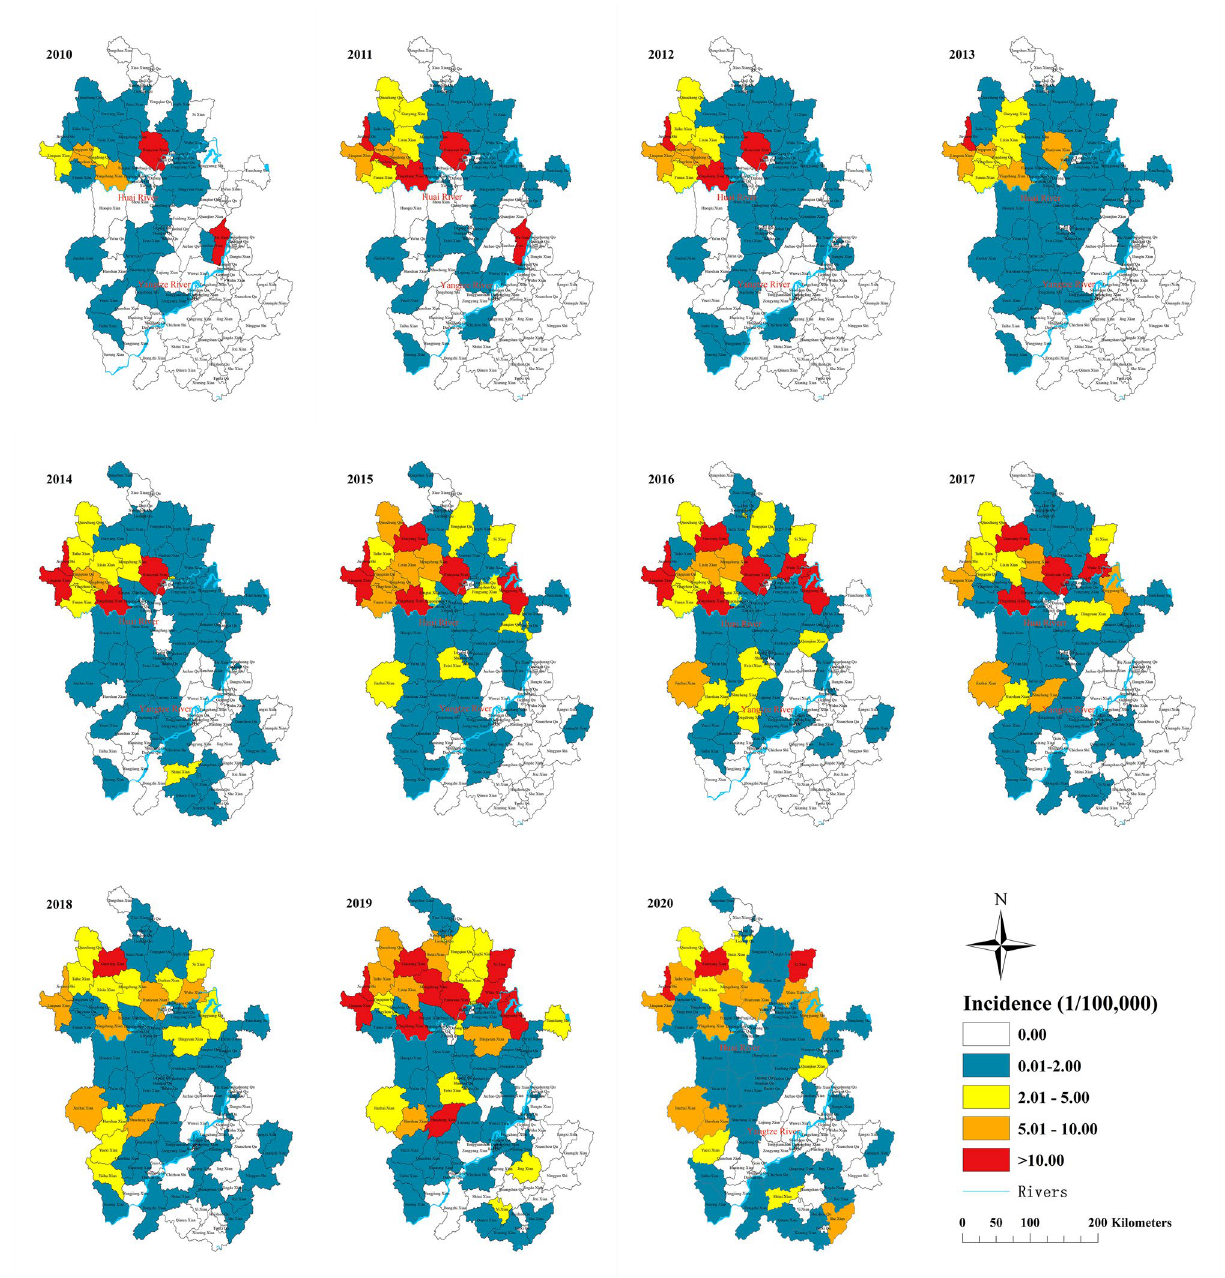
Figure 4. Spatial distributions in the annual incidence of scrub typhus in Anhui, China during 2010–2020. The base layer of the map was obtained from Resource and Environment Science and Data Center (https:// www. resdc. cn/ Datal ist1. aspx? Field TyepID=